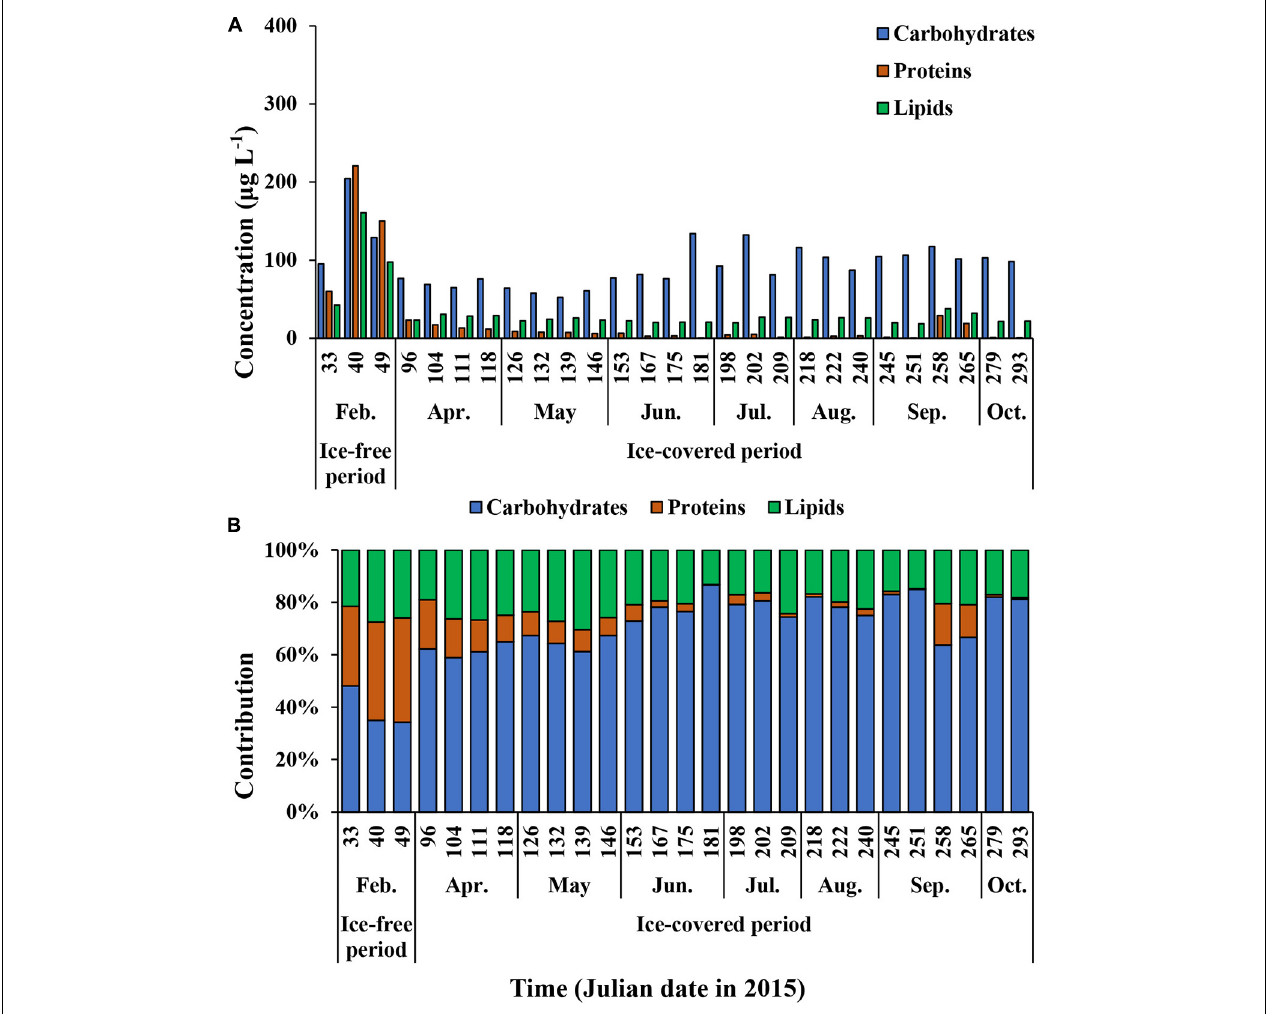
FIGURE 7 | The carbohydrates, proteins, and lipids concentrations (A) and the contribution of each biochemical component of total ( > 0.7 µ m) POM (B) at JBS during the entire study period,